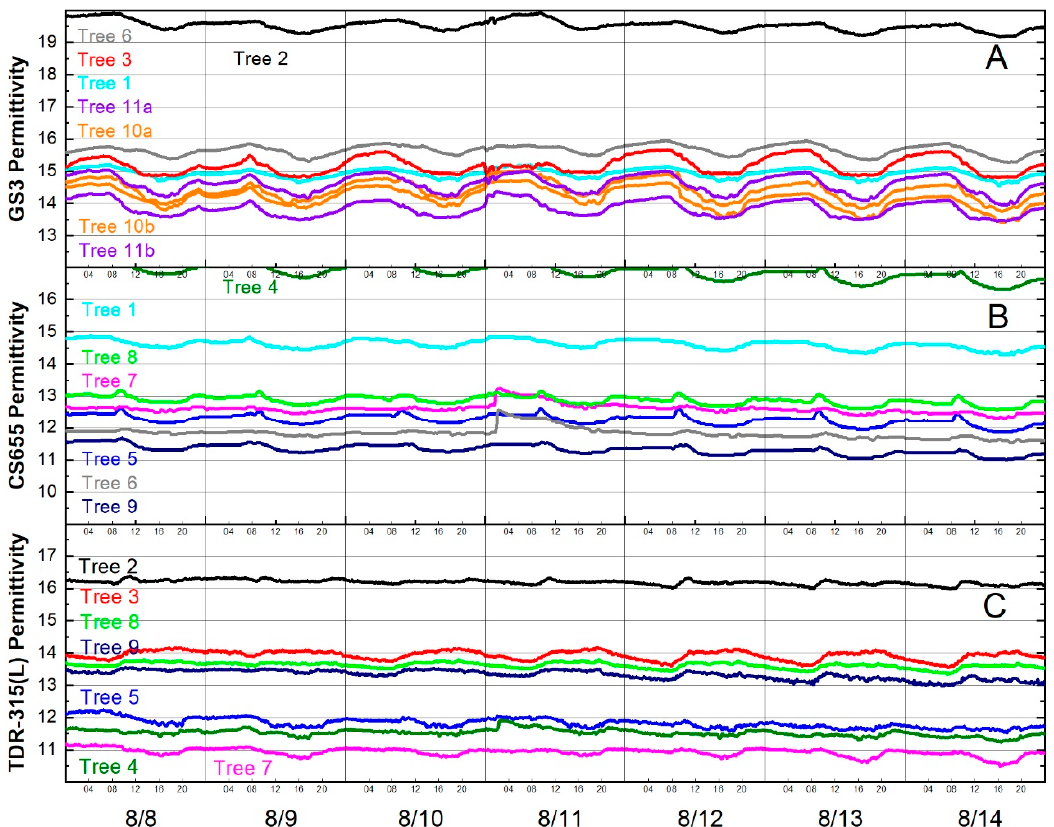
Figure 6. Diurnal fluctuations in permittivity for the week of 8 August 2016 for ( A ) GS3 sensors, ( B ) CS655 sensors and ( C ) TDR-315(L) sensors. Line colors indicate trees, not sensor models, e.g., Tree 2 had one GS3 (black line in ( A )) and one TDR-315 (black line in ( C )).